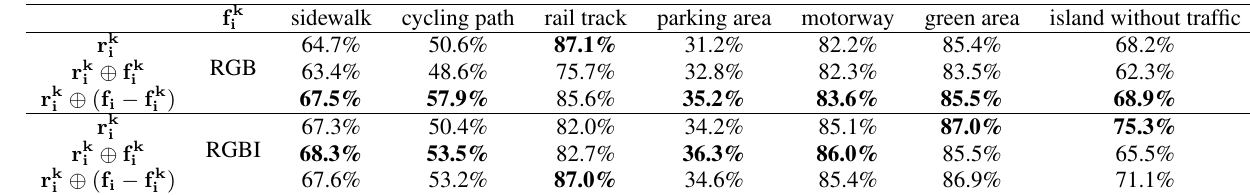
Table 3. IoU of each class among different setups in the local feature aggregation module.